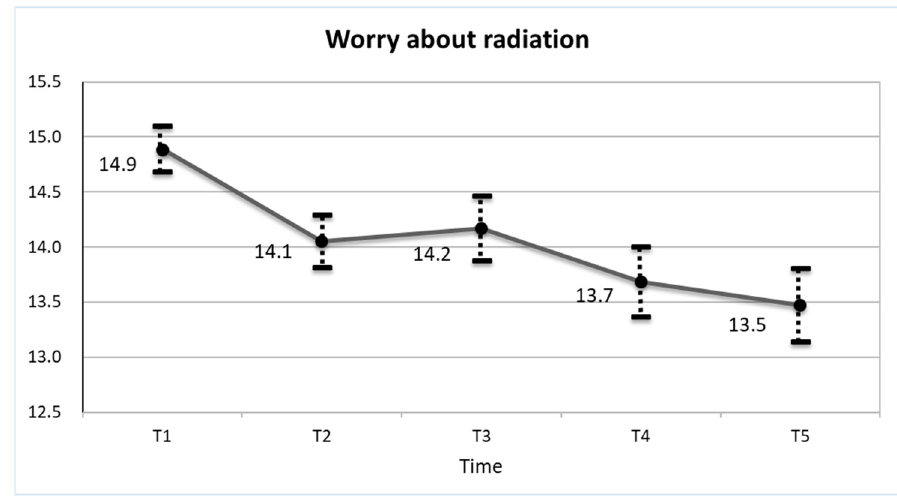
Figure 1. Time course change of worry about radiation (means and 95% confidence intervals) five to ten years after the nuclear power plant accident. T1: baseline survey or five years after the nuclear power plant accident ( n = 1754); T2: second survey or 20 months after T1 ( n = 1215); T3: third survey or 32 months after T1 ( n = 896); T4: fourth survey or 44 months after T1 ( n = 770); T5: fifth survey or 56 months after T1 ( n = 701).